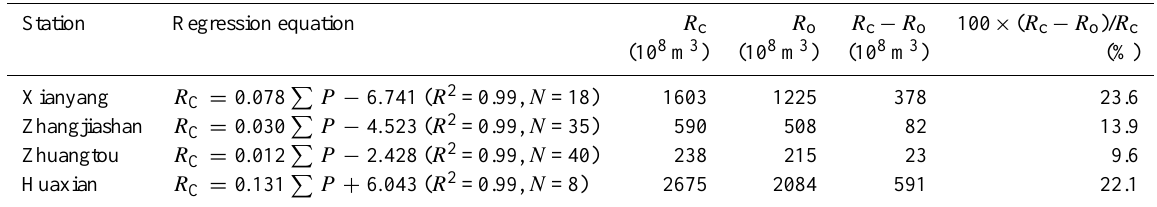
Table 4. Cumulative stream flow ( R c ) calculated by the linear regression equations before the transition years, observed cumulative stream flow ( R o ) and reduction of cumulative stream flow ( R c − R o , 10 8 m 3 %) after transition years in the Wei River basin ( N =years, P =precipitation).